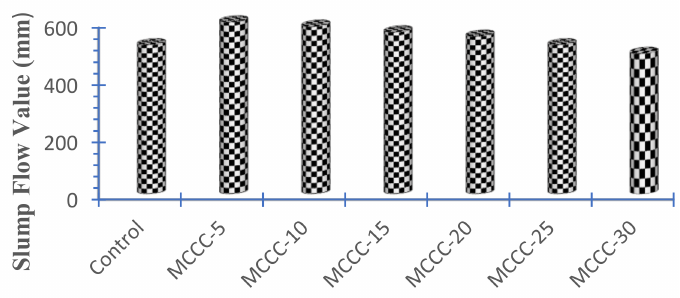
Figure 7. Slump flow of HPC made with different contents of